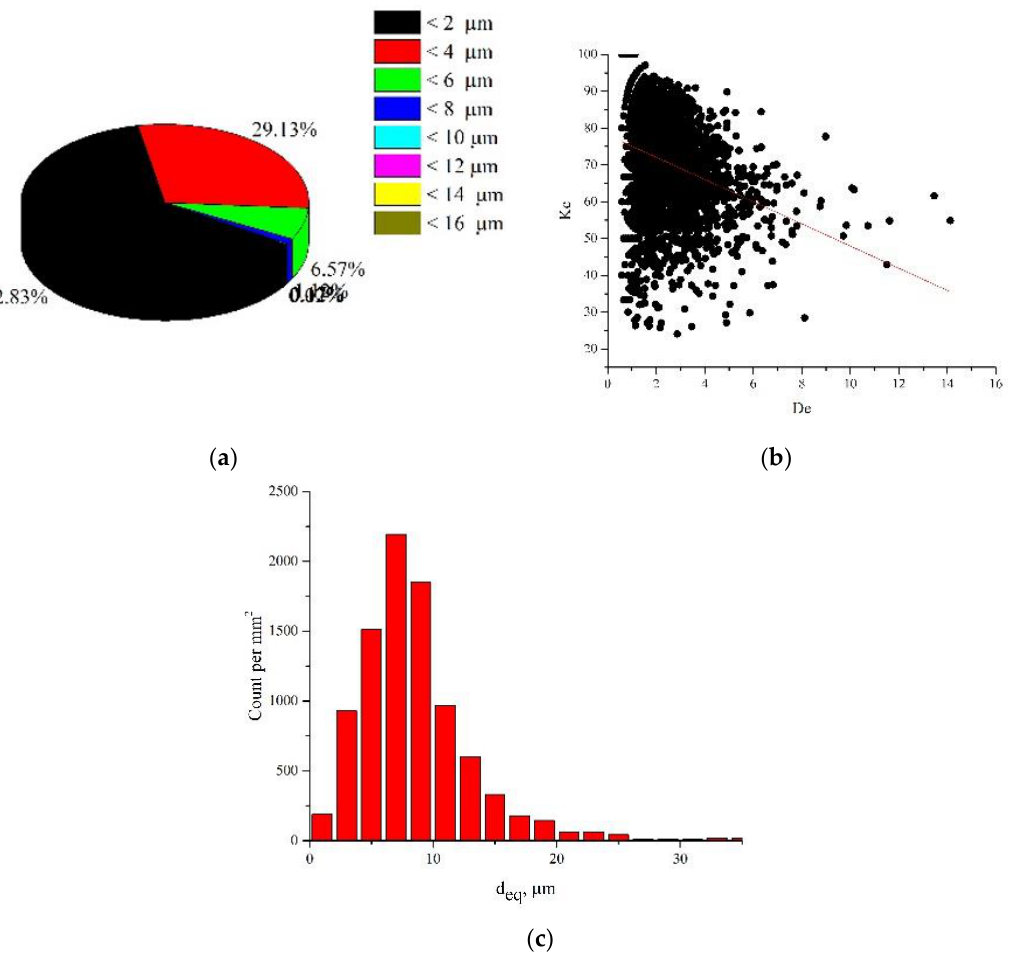
Figure 9. Distribution of sizes — ( а ); 𝐾 𝑐 dimple shape parameter — ( b ); and 𝑑 𝑒 equivalent diameter — ( с ) for the fracture surface (Figure 2 d) of alloy VT23М .